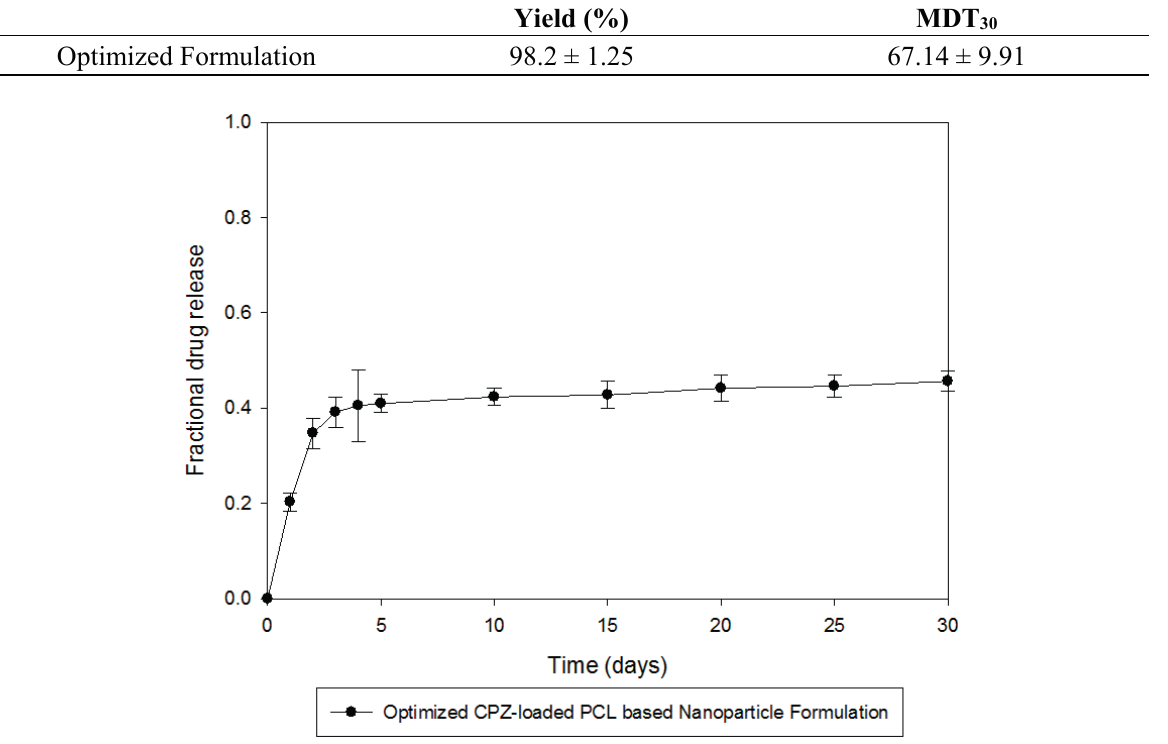
Figure 14. CPZ release from the optimized CPZ-loaded, PCL based nanocapsule